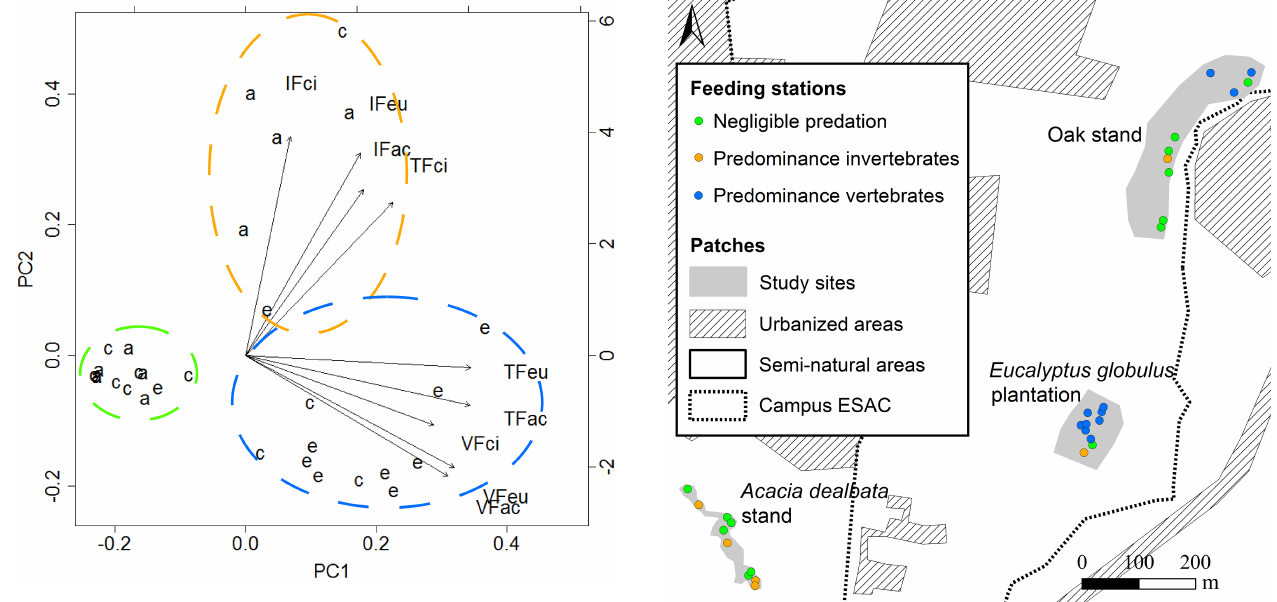
Figure 2. Biplot resulting from the PCA. Dashed circles enclose clusters of feeding stations according to the following patterns: neg- ligible seed predation (green circle); predominance of invertebrates (orange); predominance of vertebrates (blue). Letters a, c and e rep- resent the feeding stations located respectively in the A. dealbata stand, the oak stand and the E. globulus plantations. Each group of four letters represents a variable, composed by the feeder type (IF: invertebrate; VF: vertebrate; TF: total access feeder) and the seed species (ac: A. dealbata ; ci: C. salviifolius ; eu: E. globulus ).